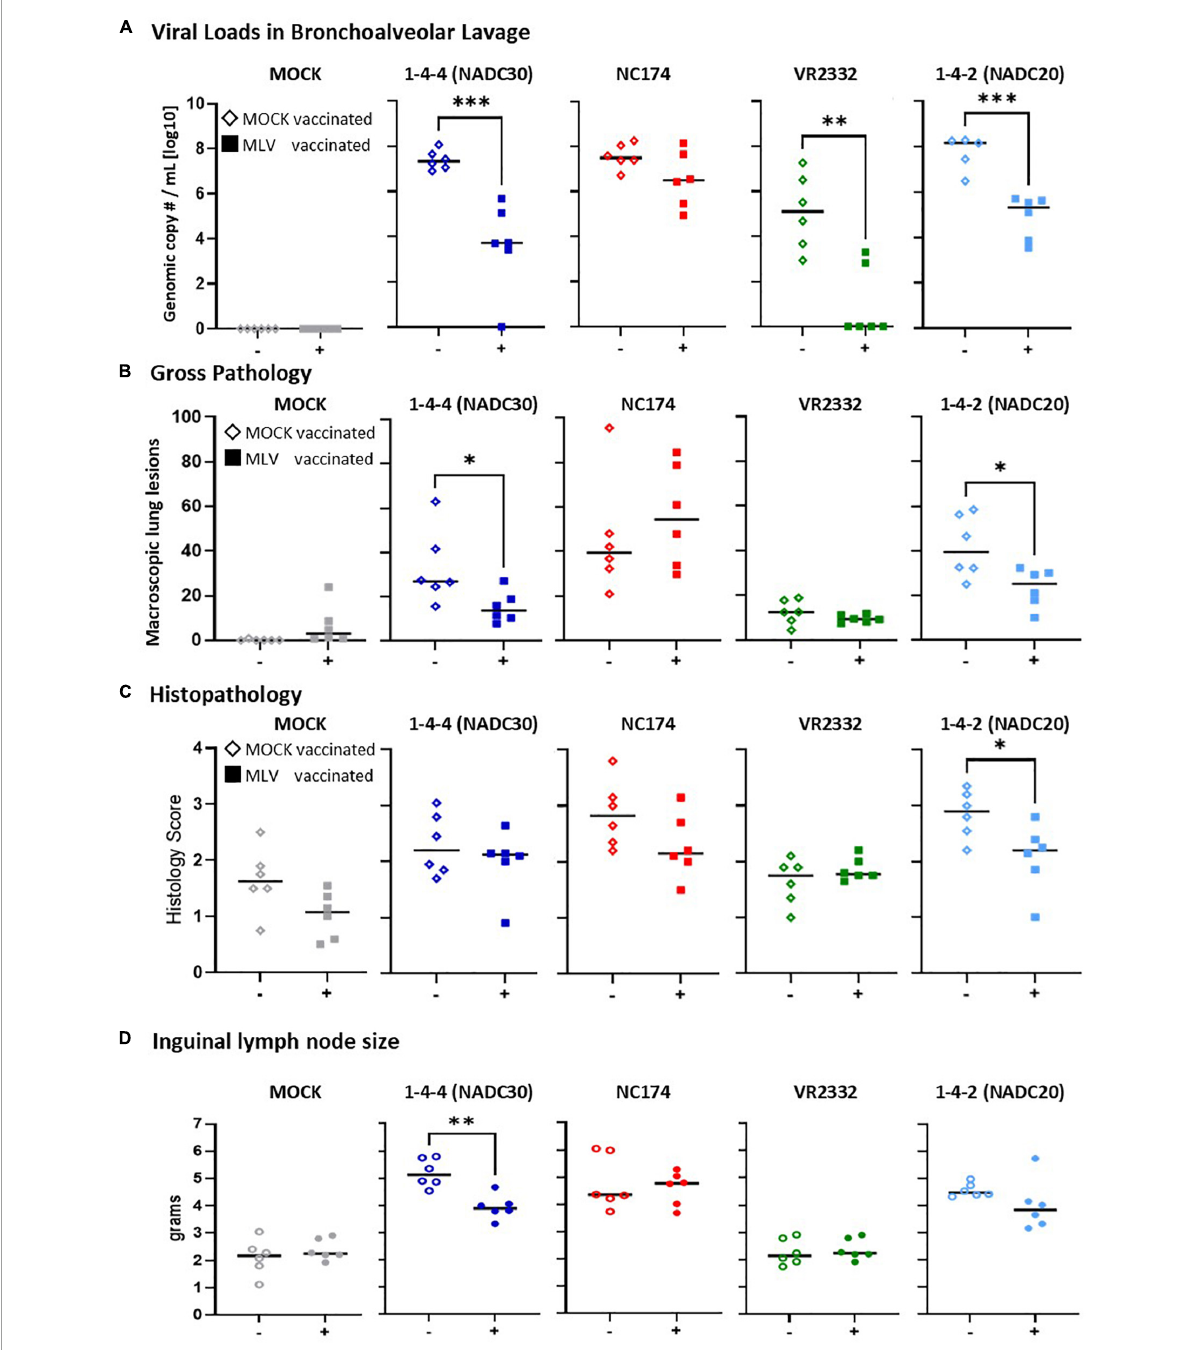
FIGURE3 Heterologous vaccine efficacy—lung viral loads, pathology, and inguinal lymph nodes size. (A) Viral loads in lung were assessed in bronchoalveolar lavage (BAL) by PRRSV-specific qPCR (genomic copy numbers/mL [log10]). Of note, while PRRSV was not detected in BAL of one MOCK-vaccinated/NADC20-challenged animal, this pig had the second highest lung pathology score combined with the highest PRRSV load in the 14 dpc nasal swab. Based on this discrepancy, it was excluded from this analysis. (B,C) Lung gross- and histopathology of all seven lobes were assessed by a blinded veterinarian at 14 days post challenge (dpc). Panel (B) depicts the percental lung lesions for each individual pig. Panel (C) shows the histopathology scores of all seven lobes following the scoring guidelines of Halbur et al. (1995). Each vaccinated group was compared to their respected PRRSV type-2 challenge unvaccinated group using a two-tailed unpaired t -test. The black bars represent the median values; in addition, individual data points are shown for MOCK vaccinated animals (open diamonds) and MLV vaccinated animals (filled squares). (D) The superficial ingual lymph nodes were collected and weighted. The average weight from the left and right lymph nodes is shown for each pig. Each vaccinated group was compared to their respective PRRSV type-2 challenge unvaccinated group. Data comparison was performed using a two-tailed unpaired t -test. *** p < 0.001, ** p < 0.01, * p <